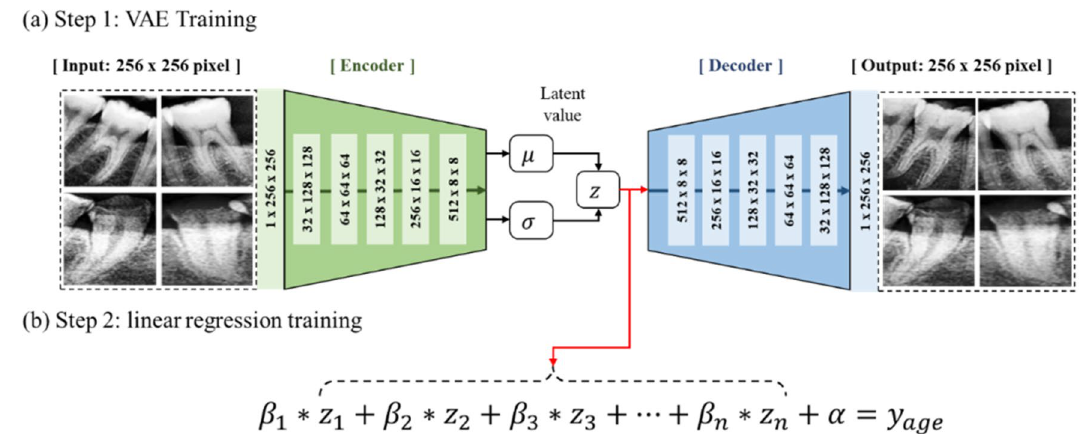
Figure 1. Structure of and training method for the variational autoencoder and linear regression model. ( a ) VAE model that can extract latent z variables from tooth images. ( b ) Regression model that can estimate age from latent z